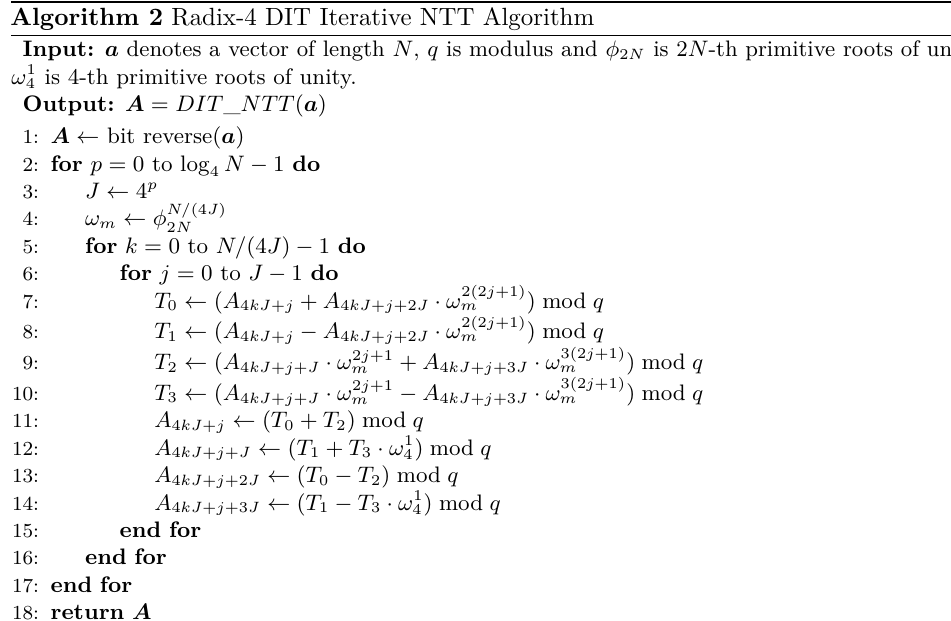
Algorithm 2 Radix-4 DIT Iterative NTT